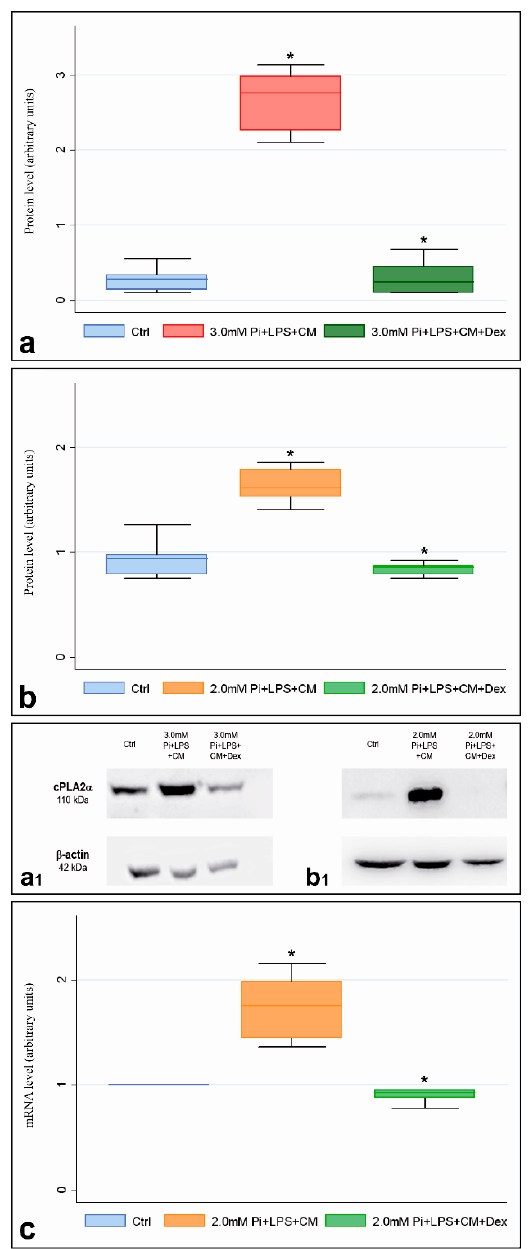
Figure 3. Effects of cPLA2 α inhibitor dexamethasone on pro ‐ calcific AVIC cultures. ( a ) Western blotting quantification of cPLA2 α in 6 ‐ day ‐ long control and metastatic calcification ‐ like cultures